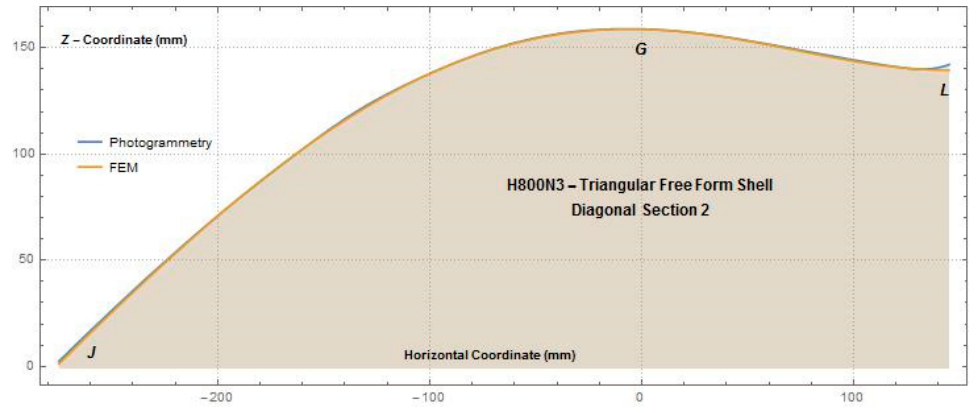
Figure 17. Diagonal cross-section defined by the plane MGH : Finite Element Method (FEM) vs. Photogrammetry curves.